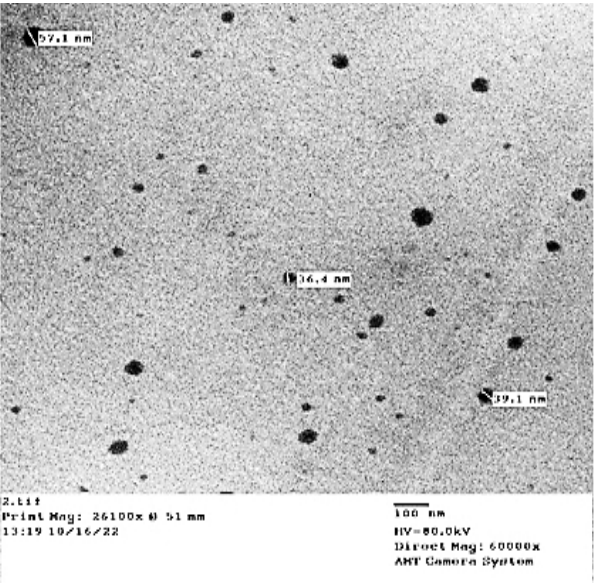
Figure 4. Transmission electron microscopic image of CEONE.